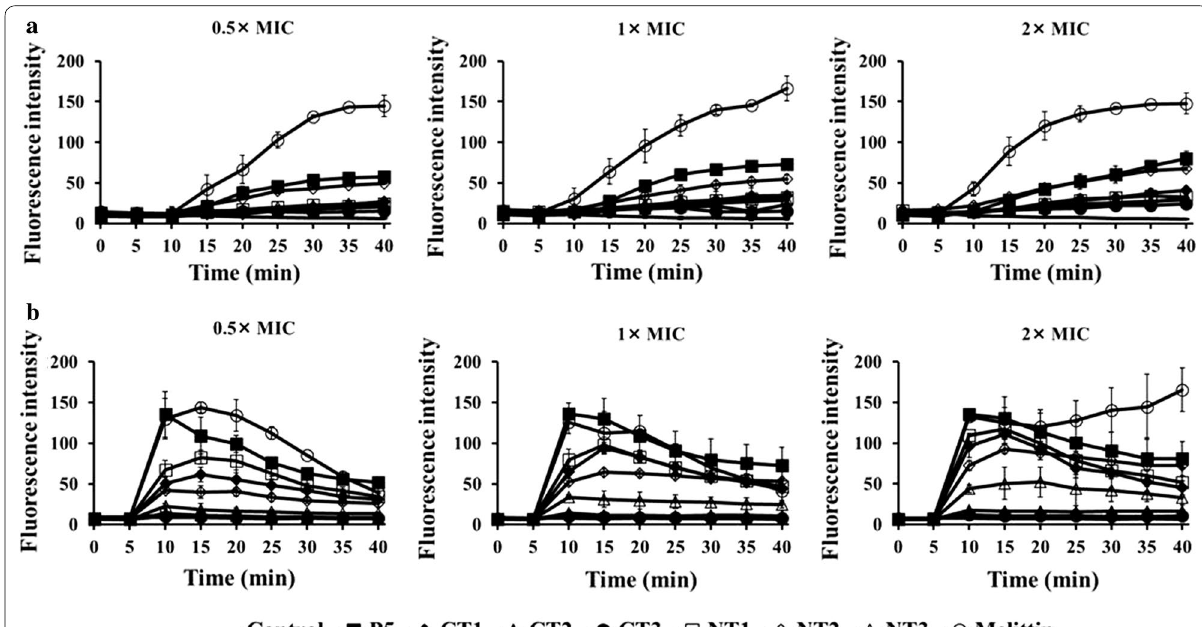
Fig. 6 Cytoplasmic membrane depolarization of a P. aeruginosa ATCC 27853 and b S. aureus ATCC 25923 was assessed by release of the membrane potential-sensitive dye 3,3 ′ -dipropylthiadicarbocyanine iodide (DisC 3 -5). MIC minimum inhibitory concentration, NPN n -phenyl-1-naphthylamine, CT C-terminus, NT